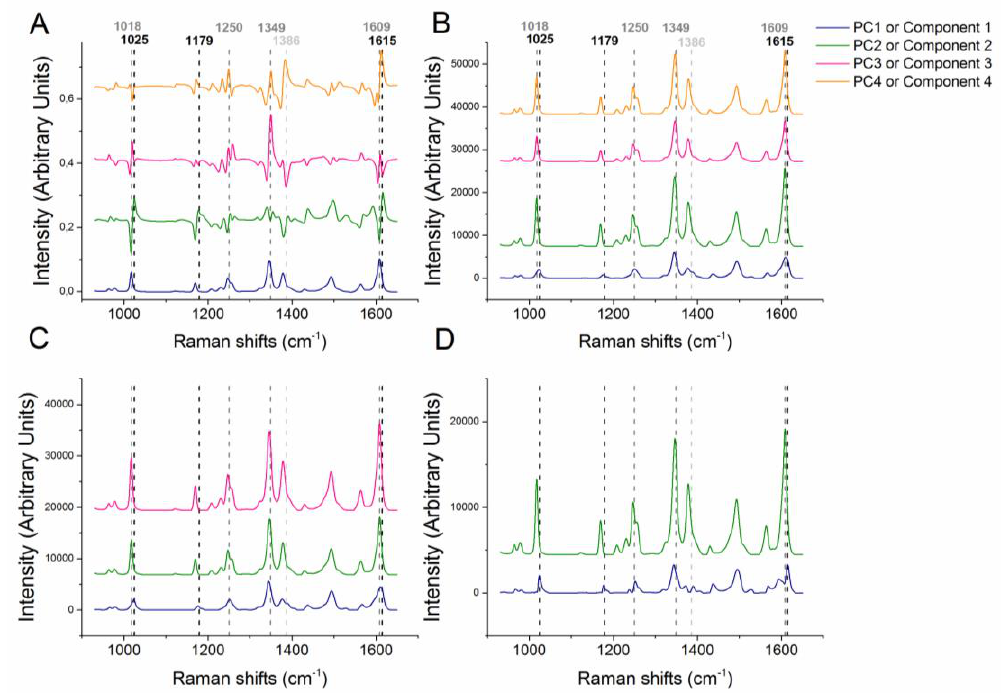
Figure 2. Loadings of ( A ) the Principal Component Analysis (PCA) model, ( B ) 4 component Multivariate Curve Resolution (MCR) model, ( C ) 3 component MCR model and ( D ) 2 component MCR model of the nitrofurantoin (NF) dataset. Dashed lines indicate significant shifts of NFMH (black), NFAH from β (dark grey) and NFAH form α (light grey).